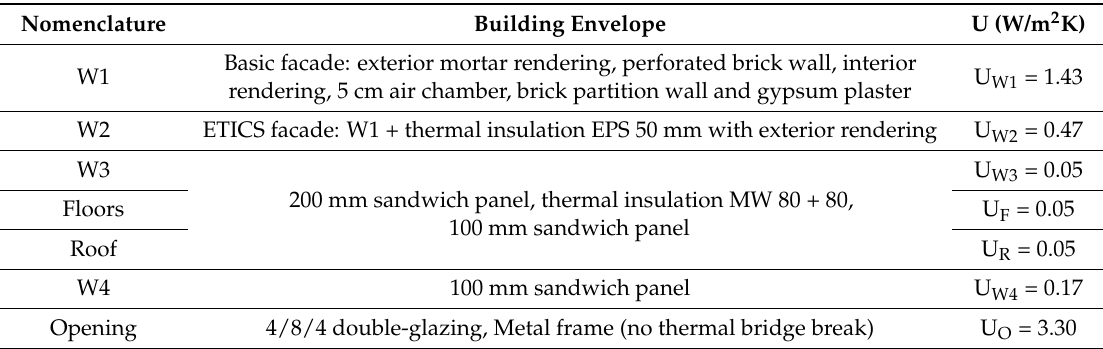
Figure 4. Constructive characterization of the basic facade (W1) and the ETICS facade (W2). Table 2. Thermal envelope definition, U-values.